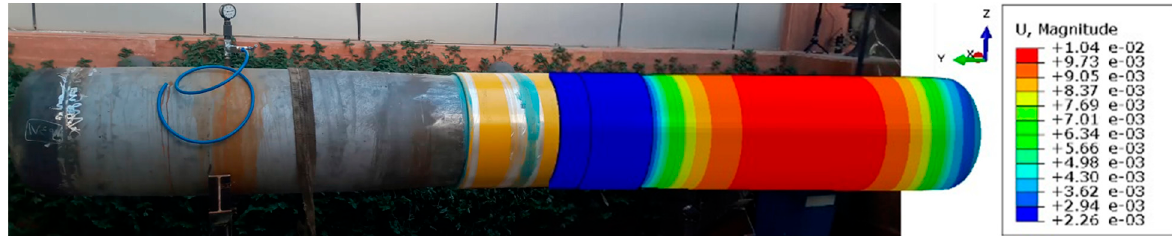
Figure 8. Deformation of experimental and numerical pipes; units in m.